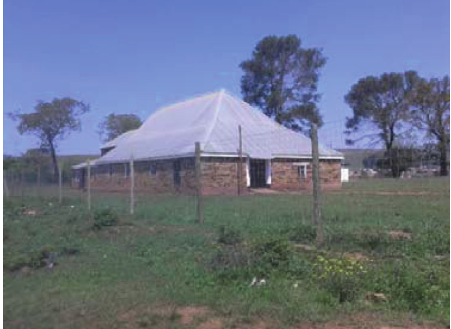
Figure 7: Church: site one.